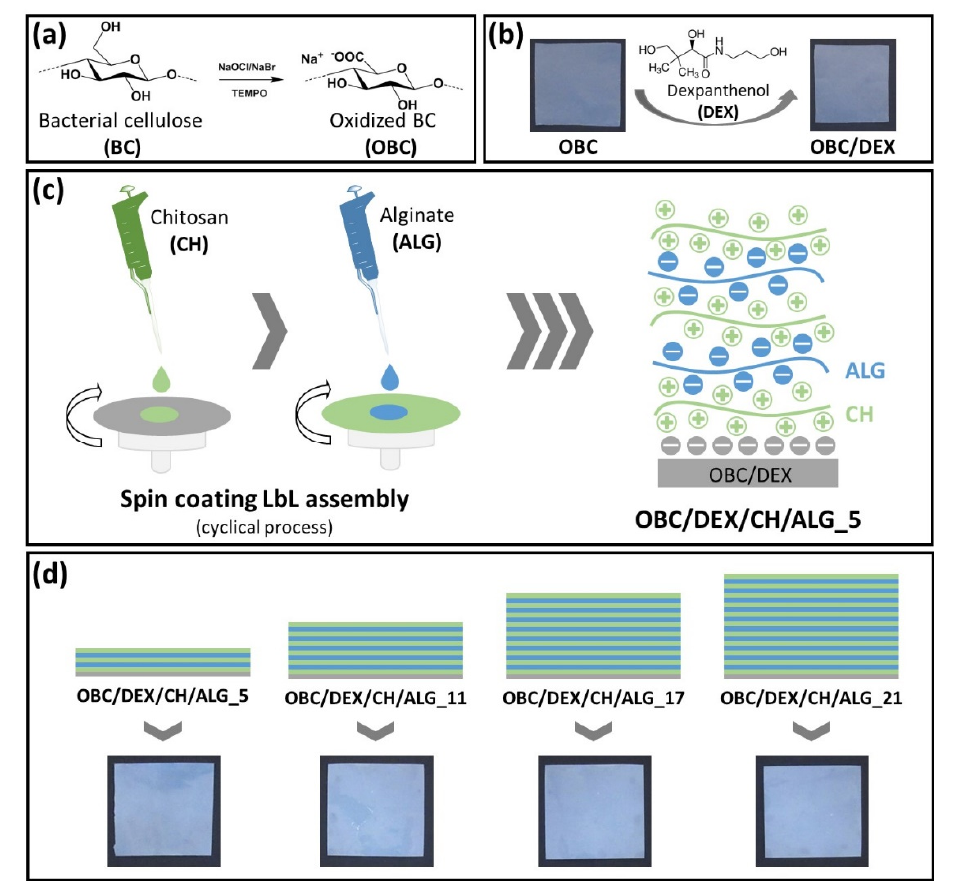
Figure 1. Schematic representation of ( a ) TEMPO-mediated oxidation of BC yielding OBC, ( b ) loading of OBC with DEX, ( c ) spin coating LbL assembly of the polysaccharides multi-layered patch with 5 layers, and ( d ) digital photographs of the OBC / DEX / CH / ALG patches with 5, 11, 17, and 21 layers. Afterward, four multi-layered patches with a distinct number of layers (5, 11, 17, and 21) of the positively charged CH ( ζ -potential: 57 ± 3 mV) and the negatively charged ALG ( ζ -potential: − 40 ± 3 mV) polyelectrolytes were prepared (Figure 1c). CH and ALG polysaccharides were selected as the